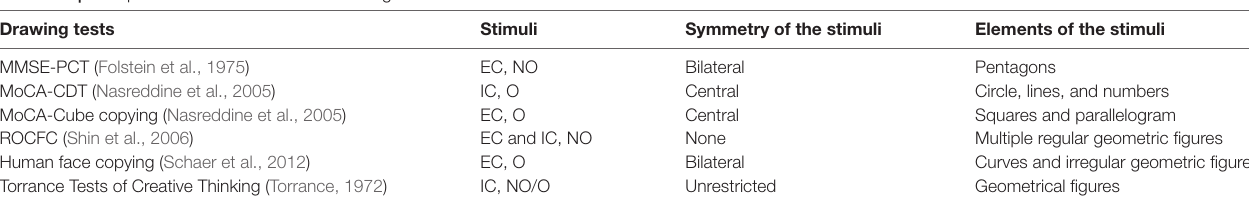
TABLE 1 | Comparison of common clinical drawing tests. Drawing tests Stimuli Symmetry of the stimuli Elements of the stimuli MMSE-PCT (Folstein et al.,